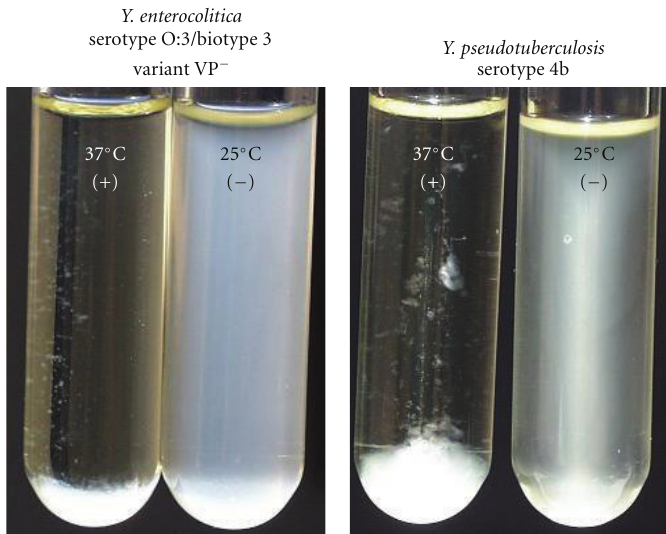
Figure 6: Autoagglutination test. Virulent plasmid-positive strains of Y. enterocolitica and Y. pseudotuberculosis produced outer membrane protein and autoagglutinate when were incubated in TSB or MR-VP medium at 37 ◦ C.